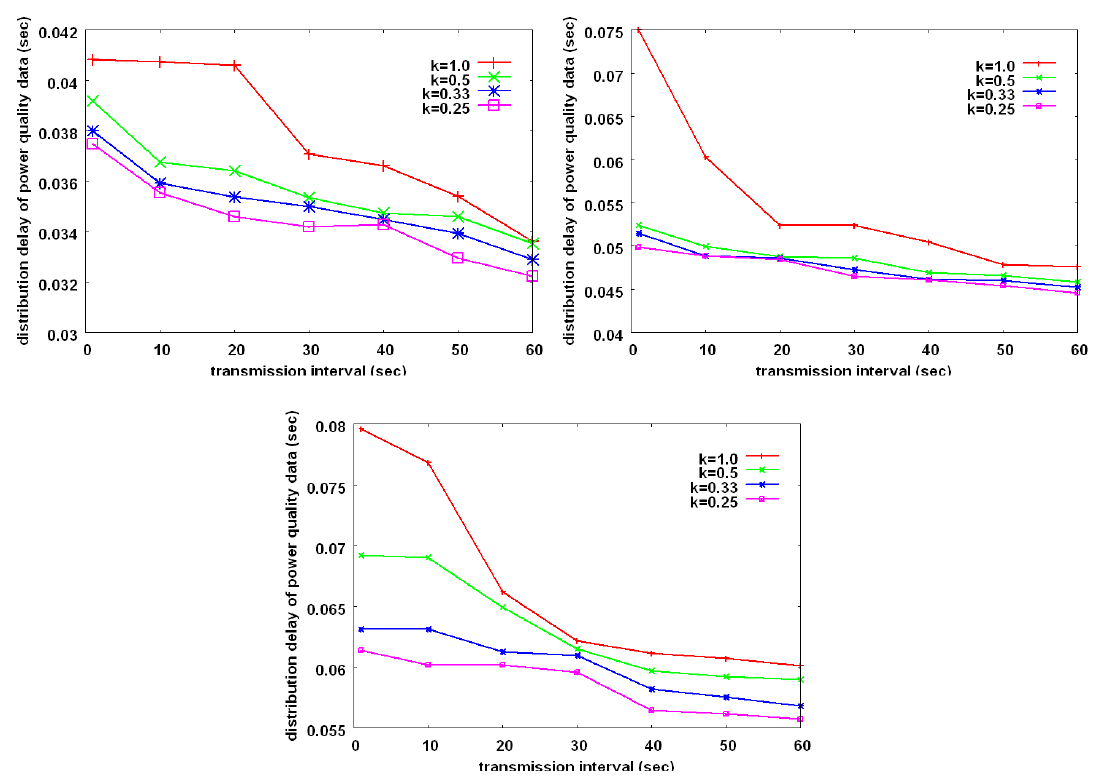
Figure 7. Distribution delay of power quality data with increasing the transmission interval. network